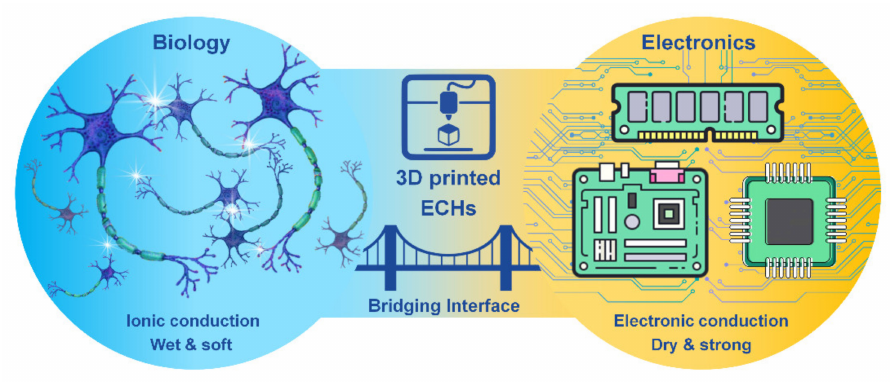
Figure 1. 3D printed electrically conductive hydrogels (ECHs) as the bridging interface of biology and